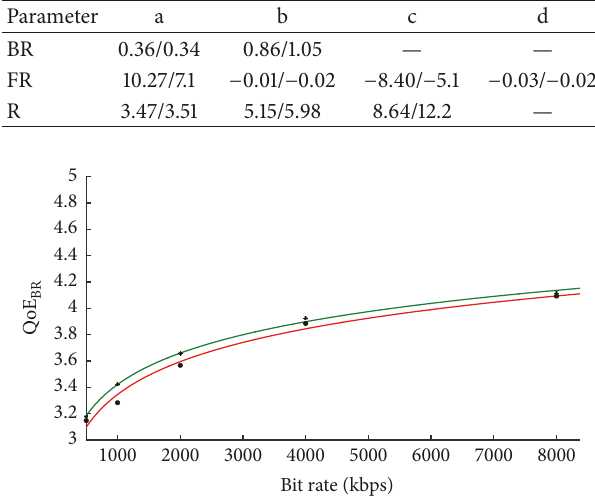
Table 18: Coefficient values for application factors.